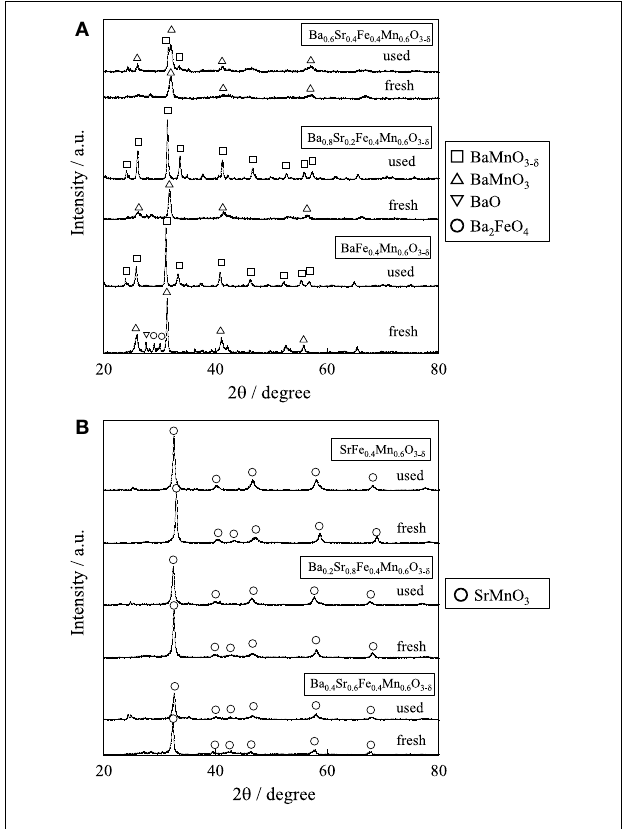
FIGURE 2 | XRD patterns for (A) Ba 1 − x Sr x Fe 0 . 4 Mn 0 . 6 O 3 − δ (0 ≤ x ≤ 0 . 4) catalysts and (B) Ba 1 − x Sr x Fe 0 . 4 Mn 0 . 6 O 3 − δ (0 . 6 ≤ x ≤ 1) catalysts.